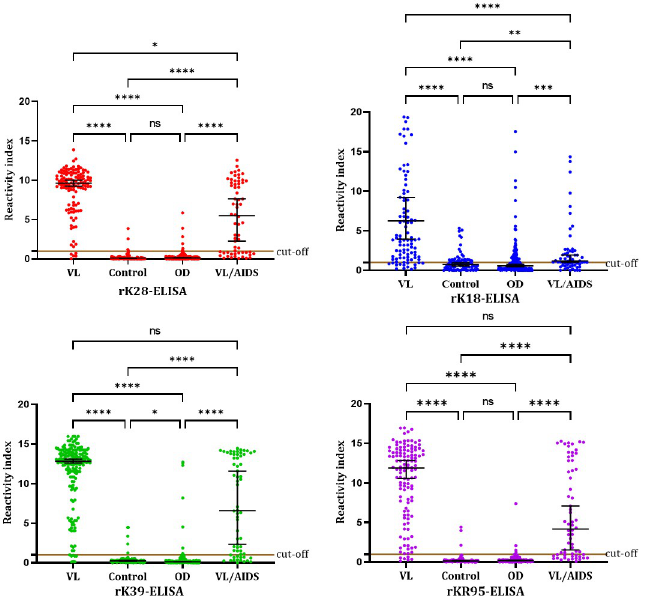
Fig 5. Reactivity indices obtained by rK28-ELISA, rK39-ELISA, rK18-ELISA, and rKR95-ELISA with 122 samples from VL patients, 83 samples from healthy controls, 190 samples from patients with other diseases, and 64 samples from VL / AIDS patients. The horizontal black lines represent the median ABS% Positive Control values with a 95% confidence interval. Kruskal-Wallis’s: p < 0.0001 (for the four antigens). Dunn’s multiple comparisons test: rK28: � —p = 0.0327; ���� —p < 0.0001; ns—p = 0.6551. rK39: � —p = 0.0262; ���� —p < 0.0001; ns—p = 0.0515. rK18: �� —p = 0.0025; ��� —p = 0.0003; ���� —p < 0.0001; ns—p > 0.9999. rKR95: ���� —p < 0.0001; ns—p > 0.9999 (control x other diseases) and p = 0.1357 (VL x VL /